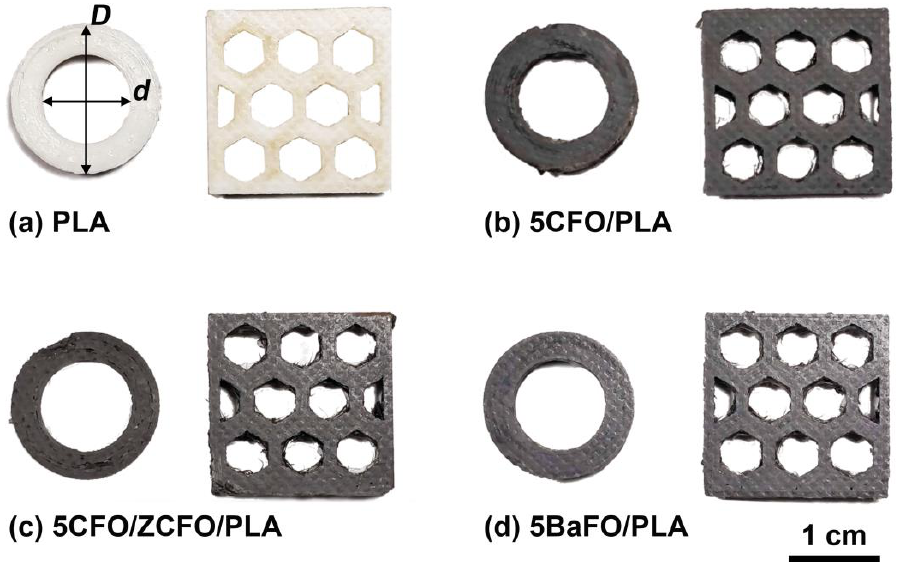
Figure 4. Pictures of objects printed with a 3D printer from the pure and composite PLA-based fila- filament: ( a ) pure PLA; ( b ) 5CFO/PLA, ( c ) 5CFO/ZCFO/PLA, and ( d ) 5BaFO/PLA ment: ( a ) pure PLA; ( b ) 5CFO/PLA, (c) 5CFO/ZCFO/PLA, and ( d ) 5BaFO/PLA composites.